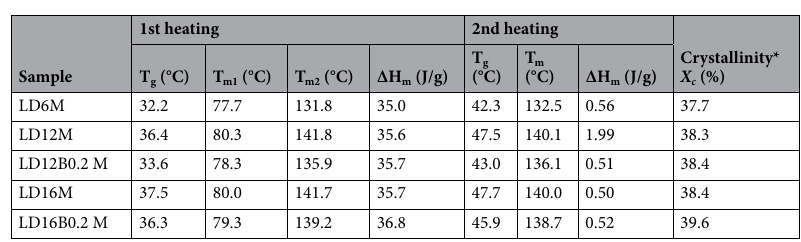
Table 2. Summary of thermal properties of various alcohol-acidolyzed PLA products, derived from the 1st to 2nd heating scan DSC thermograms. *Calculated from the 1st heating scan thermogram, X c (%) = ( ΔH m - ΔH c ) × 100/ ΔH °, where ΔH ° (93